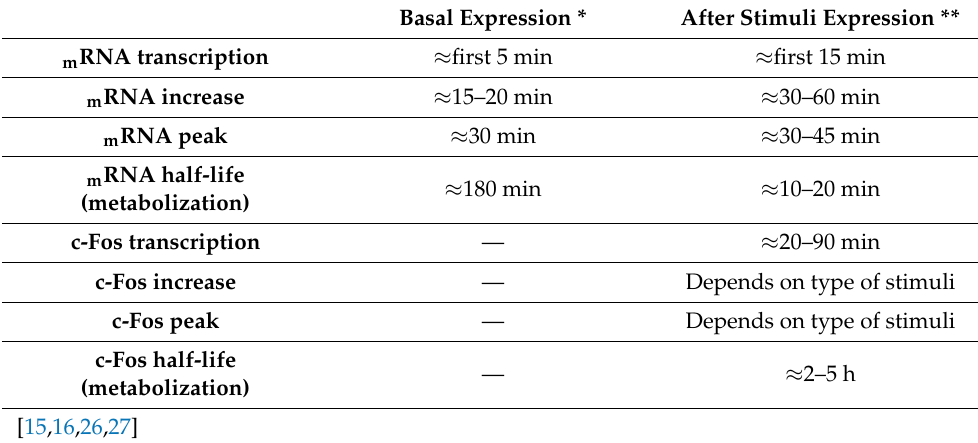
Table 3. Expression time of c-Fos and c-fos (basal and after stimuli). Basal Expression * After Stimuli Expression ** m RNA transcription ≈ first 5 min ≈ first 15